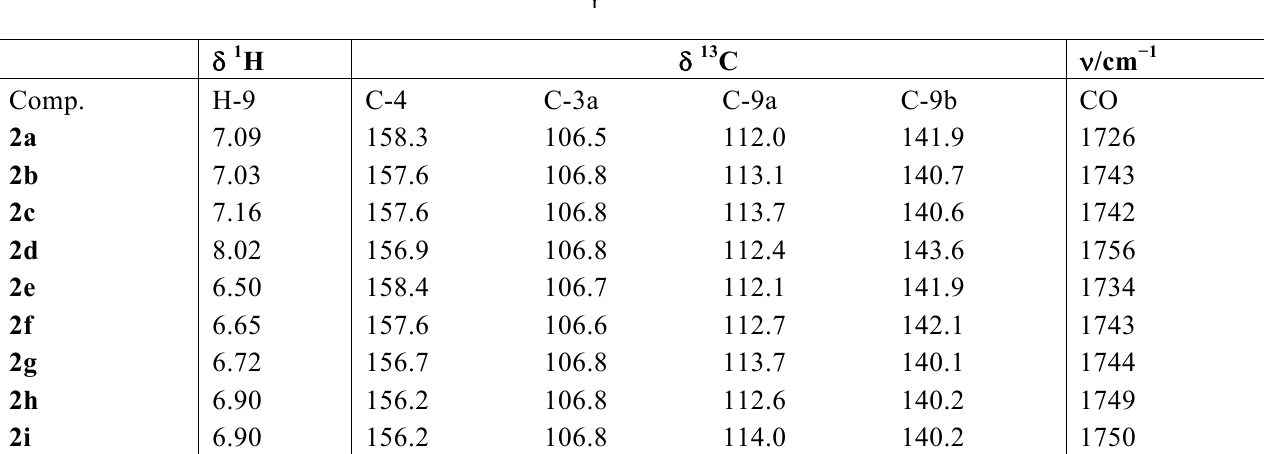
Table 2. Selected NMR and IR spectroscopic data for pyrazoles 2a-i .